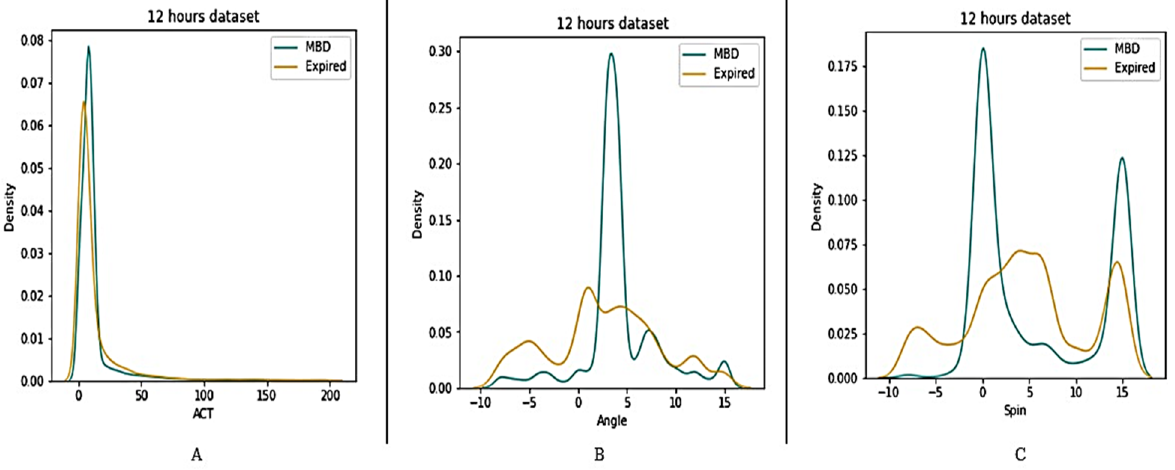
Figure 5. Description of wearable dataset at 12 h interval based on ( A ) ACT, ( B ) Angle ( C ) Spin.